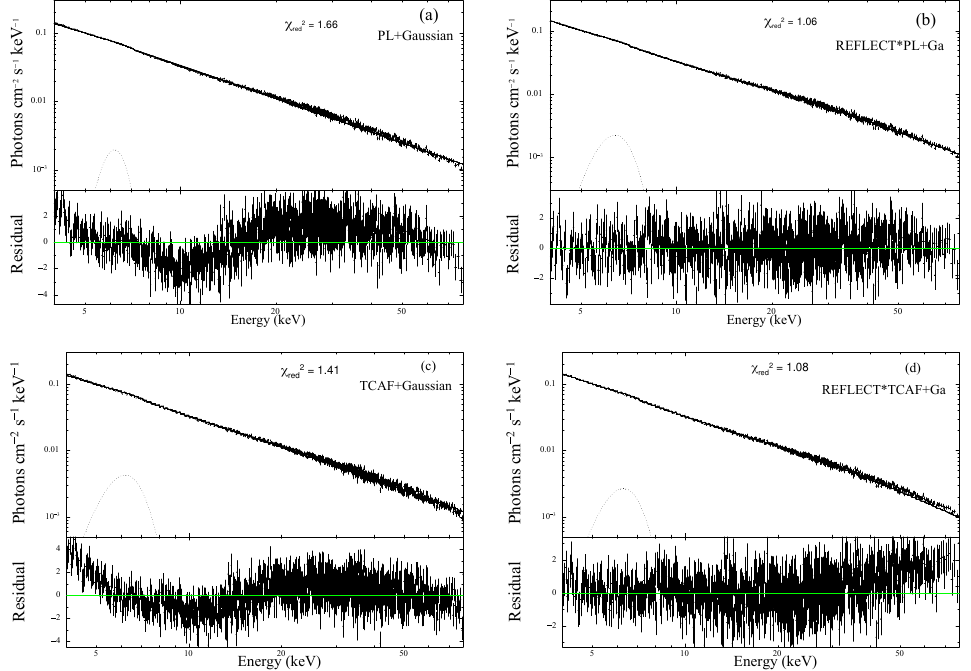
Figure 5. Fitted spectrum of NuSTAR of OBSID 80502304002 (MJD = 58,655.60) in the energy range 4–78 keV with ( a ) PL+Gaussian model, ( b ) REFLECT *PL+Gaussian model, ( c ) TCAF+Gaussian model and ( d ) REFLECT *TCAF+Gaussian model.